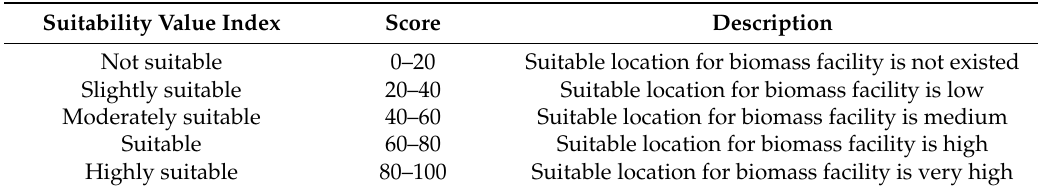
Table 3. Index of suitability value for classifying biomass facility